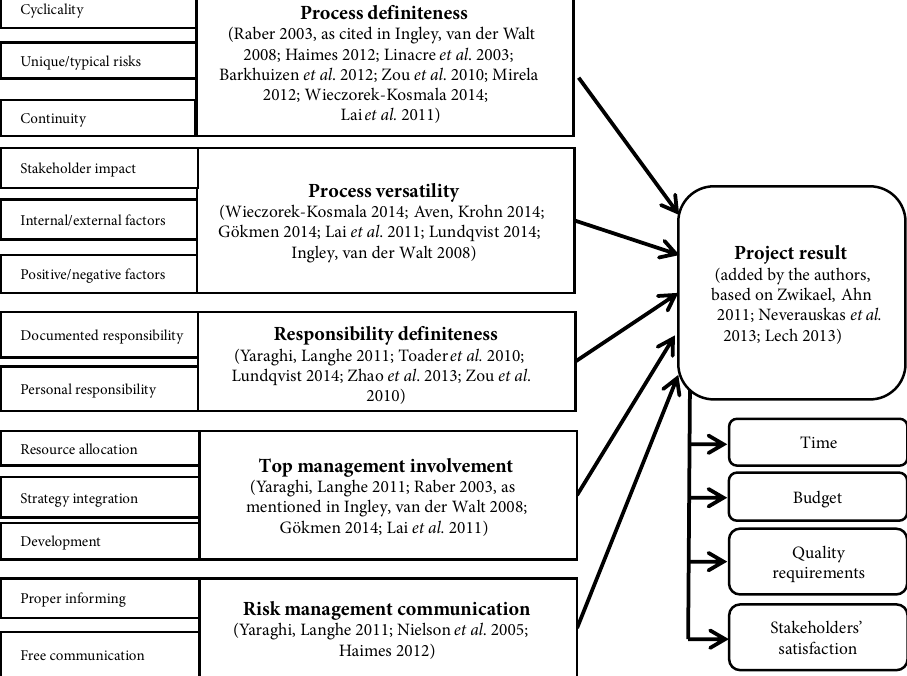
Figure 1. A conceptual model articulating the criteria of language translation project risk management and project